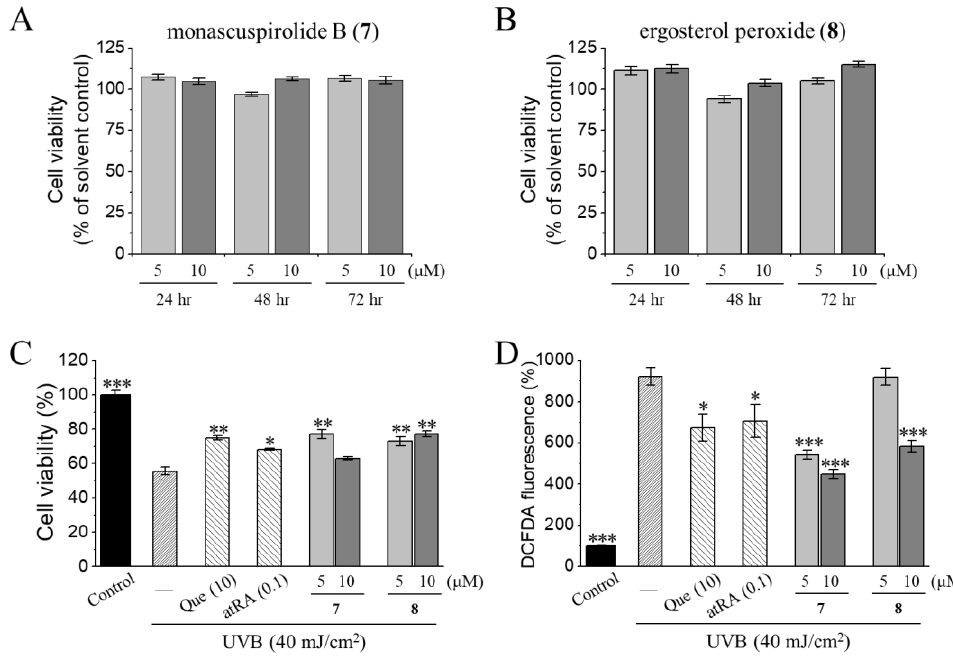
Figure 8. Photoprotective activities of monascuspirolide B ( 7 ) and ergosterol peroxide ( 8 ) in HaCaT cells. ( A , B ) Monascuspirolide B ( 7 ) ( A ) and ergosterol peroxide ( 8 ) ( B ) had no cytotoxicity on the HaCaT cells. After treatment, cells were incubated with 10% volume of alamarBlue ® reagent to determine cell viability. ( C , D ) Protective effects of monascuspirolide B ( 7 ) and ergosterol peroxide ( 8 ) against UVB-induced cell viability loss ( C ) and ROS overproduction ( D ). Cells were pre-incubated with vehicle control or testing compounds for 6 h and then subjected to UVB irradiation. After irradiation, cells were incubated for another 24 h. Intracellular ROS was measured using H2DCF-DA, a cell-permeable fluorescent indicator for intracellular ROS production. Quercetin (Que, 10 μM) and all- trans retinoic acid (atRA, 0.1 μM) were used as the reference control. Data were normalized with the basal group and presented as mean ± SEM from at least three independent experiments. * p < 0.05. ** p < 0.01. *** p < 0.005 (compared to the UVB-irradiated group).